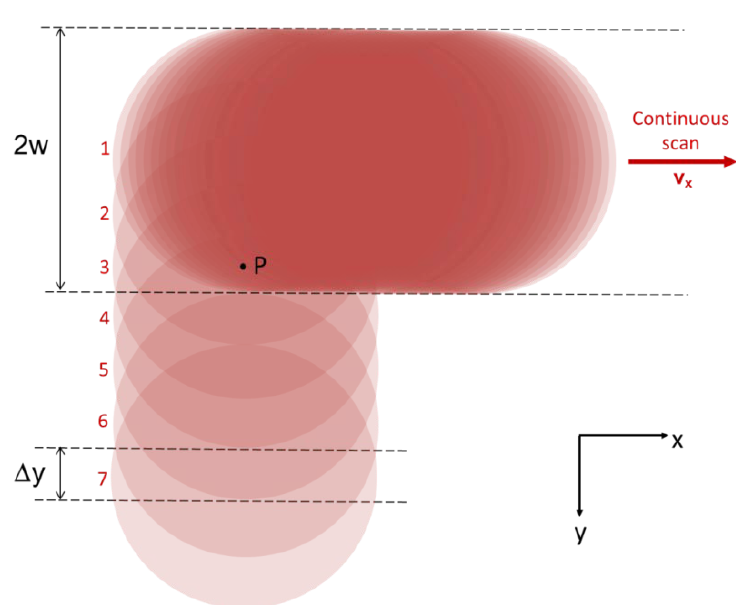
Figure 2. Raster scan pattern used for the femtosecond (fs)-laser treatment of the printed carbon strips. Note that the point P is subjected to five horizontal laser scans (#1 to #5), whereas it is not irradiated during scans #6 and #7.